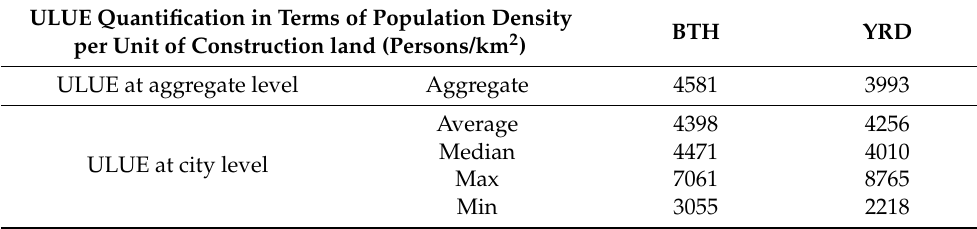
Table 3. ULUE values obtained for the population density per unit of construction land in the BTH and YRD urban